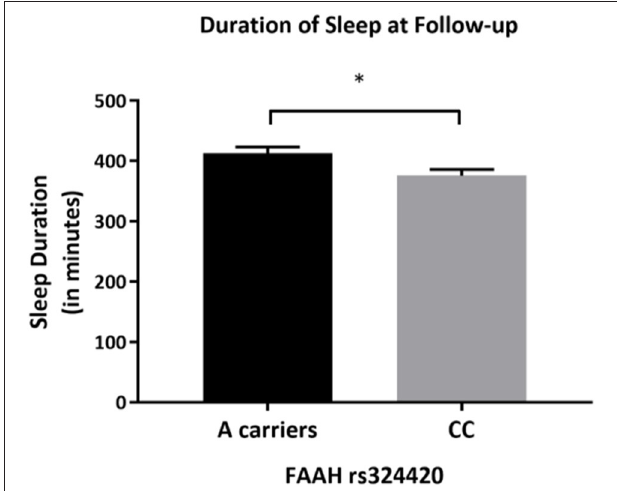
FIGURE 4 | Differences in actigraphy-based sleep quality measures by FAAH rs324420 genotype at follow-up. This figure demonstrates that at follow-up, the CC FAAH rs324420 genotype had lower sleep duration (based on actigraphy) after controlling for age, sex, years of education, pack years, Alcohol Dependence Severity (ADS) scores, Ancestry-informative marker (AIM scores for Africa, Europe), presence of mood disorders, and/or anxiety disorders, presence of Cannabis Use Disorder, and/or any Substance Use Disorder other than nicotine [ F (1,65) = 5.944, p = 0.018]. Bars represent adjusted means and error bars denote standard errors. * p < 0.05.